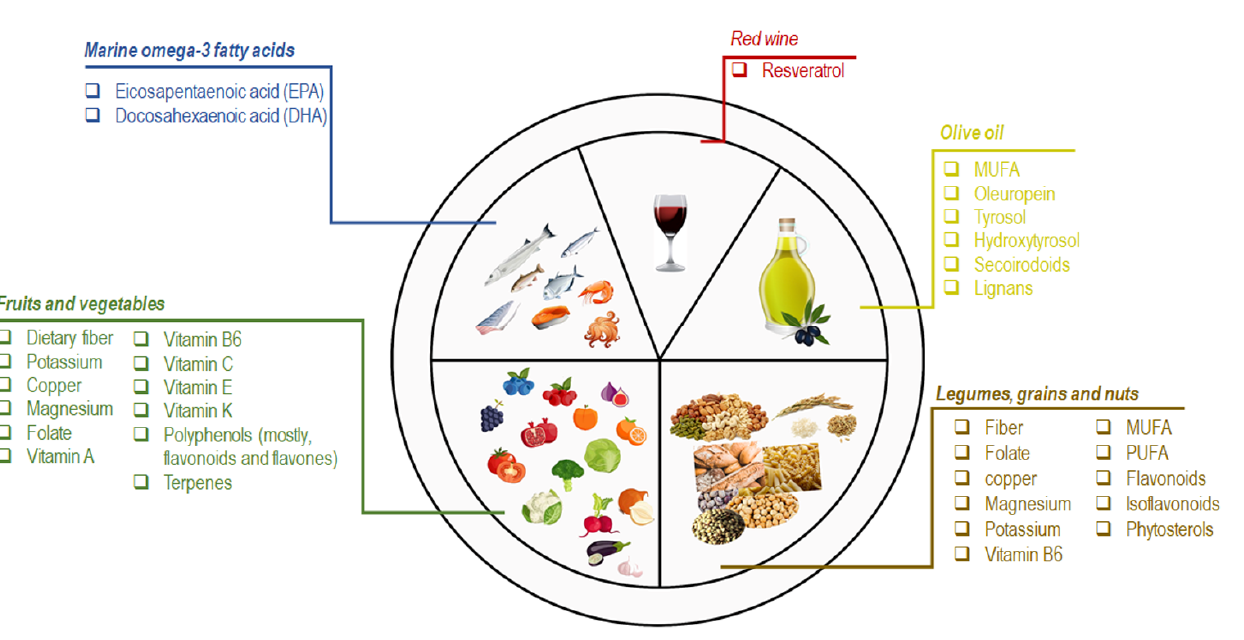
Figure 1. Schematic representation of the nutritional and bioactive characteristics of the principal components of the MedDiet.